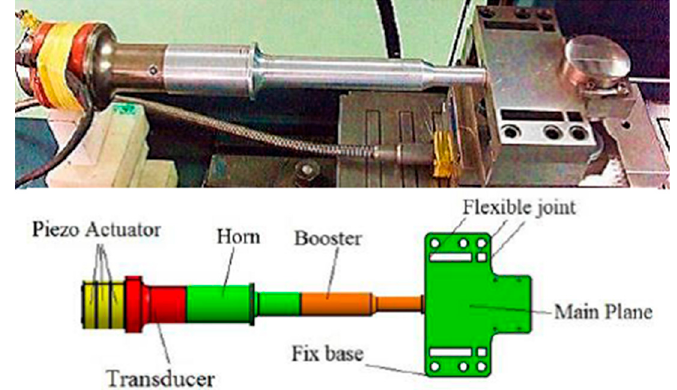
Figure 1. Ultrasonic vibration system [3].